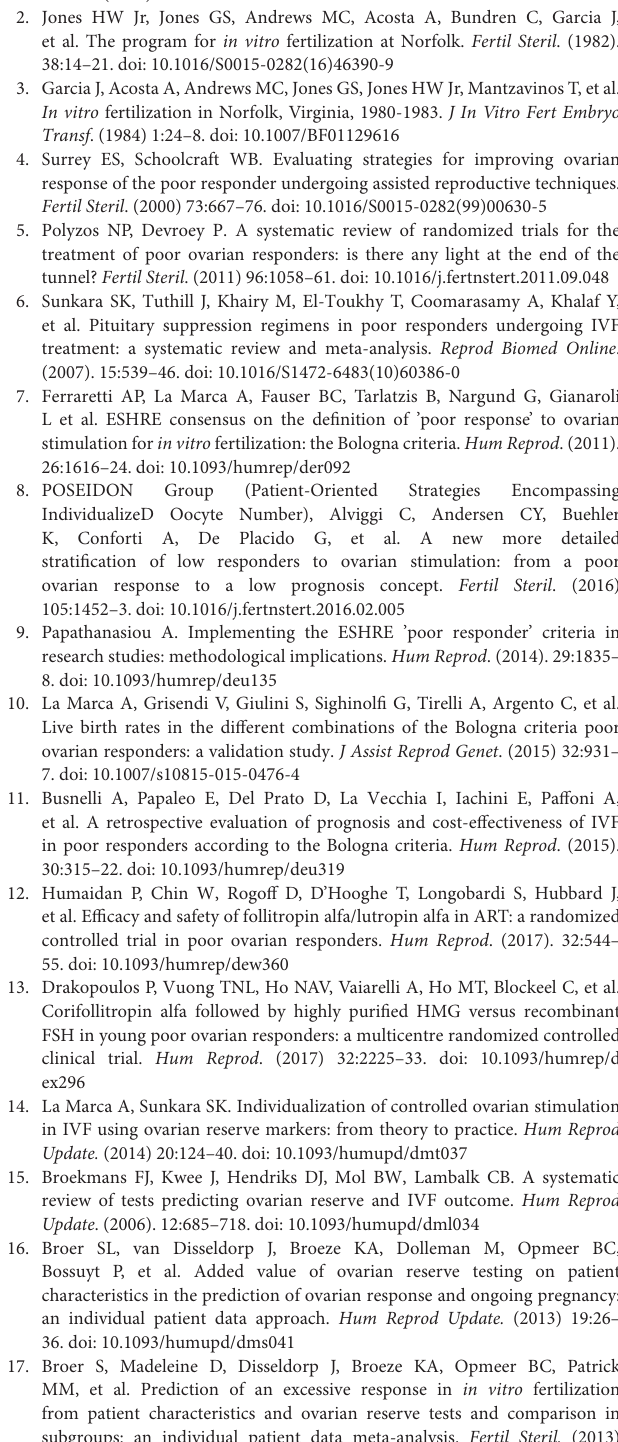
Decision points for individualized hormonal stimulation with